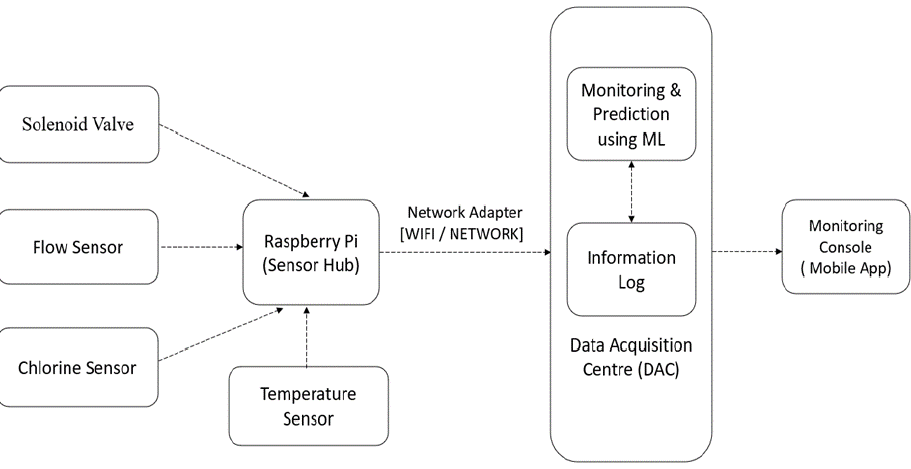
Figure 2. Proposed chlorine content assessment and recommendation in drinking water using ML.